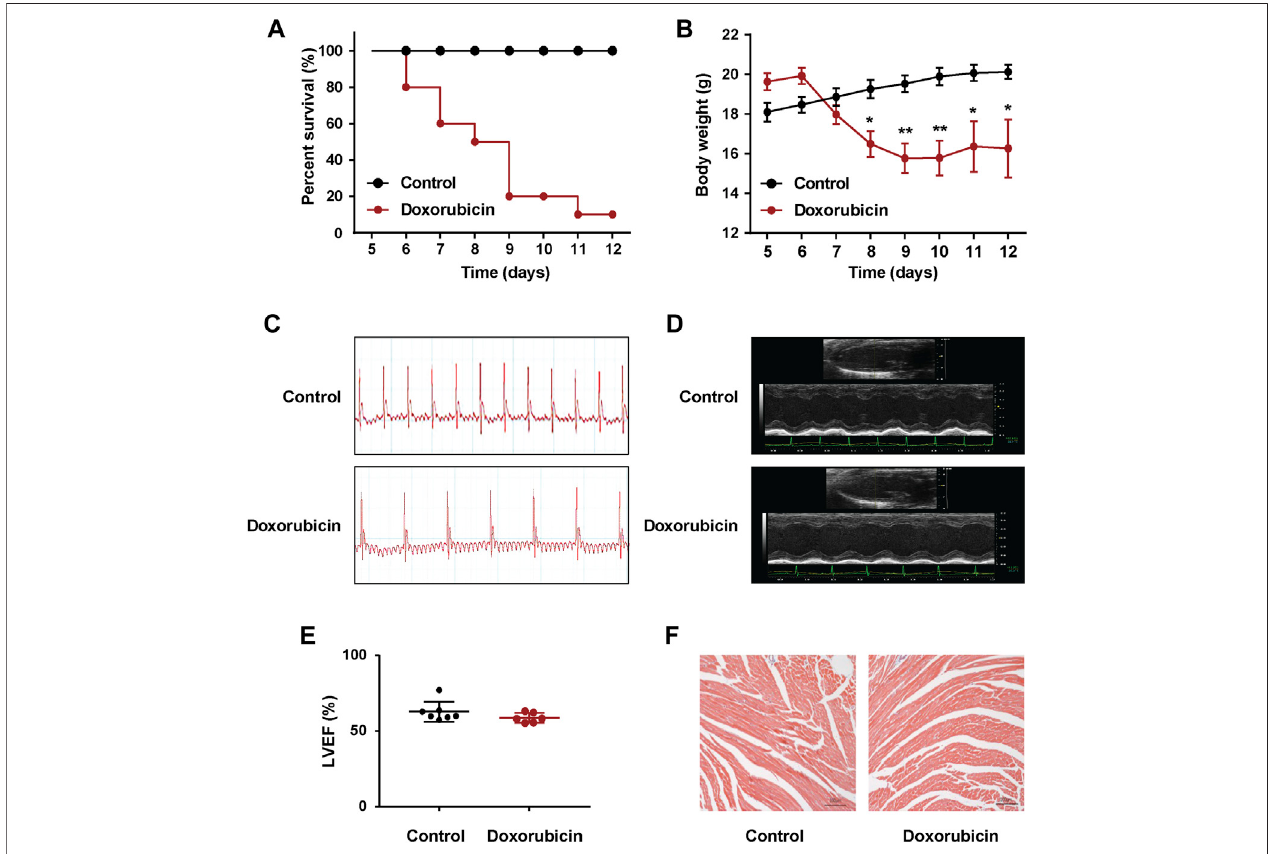
FIGURE 1 | Doxorubicin signi fi cantly induces abnormal heart rhythm in mice. Mice received a single administration of doxorubicin (20 mg/kg, i.p.) or vehicle (0.9% NaCl, i.p.). (A) Kaplan Meier survival analysis showed that the survival rate of doxorubicin-treatment mice. The Log rank (Mantel-Cox) test was used to determine signi fi cance( n =10ofeach group). (B) Bodyweights wasmeasured everyday forconsecutive 12 days. (C) Representativeimages ofelectrocardiogram(ECG), and (D) echocardiography were examined on Day 7 after doxorubicin administration. (E) Quantitative data of the LVEF values in mice. (F) Masson staining of myocardial sections in mice. Magni fi cation: ×100. Scale bar: 100 μ m. ( n = 4 of each group). Signi fi cant difference was revealed following one-way ANOVA (* p < 0.05, ** p < 0.01 vs. Control group; Bonferroni post hoc